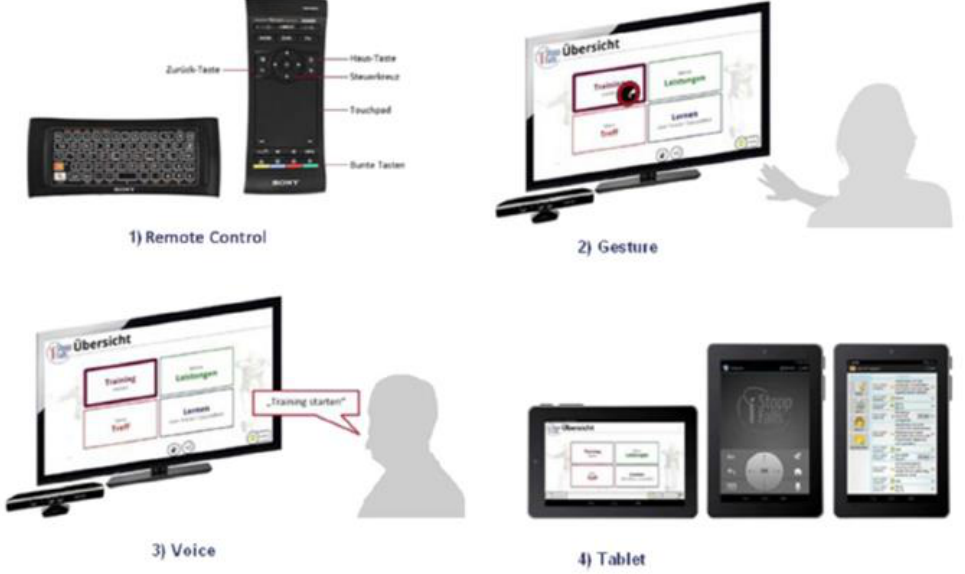
Figure 2. The different modes of interaction available to users of the iStoppFalls ICT-based system. (Permission granted by the Dr Rainer Wieching—PI, [57]). ( 1 ) Remote control, ( 2 ) gesture, ( 3 ) voice or ( 4 ) tablet.